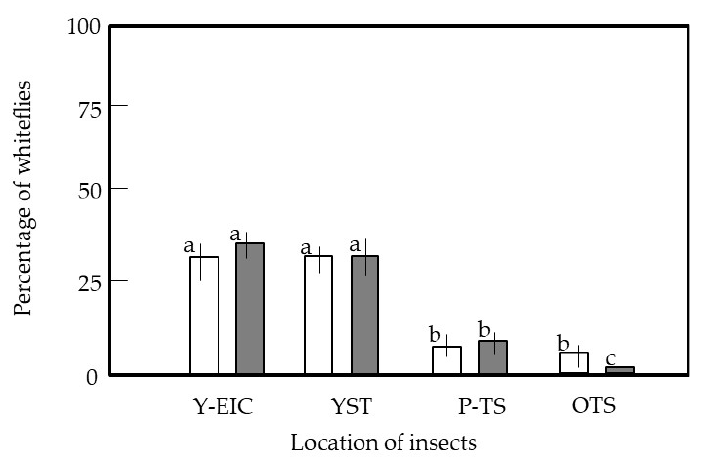
Figure 9. Assay of the preferential attraction of whiteflies to a yellow-colored electrostatic insect catcher (Y-EIC), a yellow sticky trap (YST), and a potted tomato seedling (P-TS), which were placed in concyclic positions at equal distances. A vessel containing test insects was placed at the central position of a circle. Adult whiteflies were used as test insects. In all experiments, the destinations of test insects were recorded 1 day (open) and 2 days (gray column) after their release. OTS represents other places, such as in the vial or on the floor, wall, and ceiling of the cabinet. Twenty insects were used in each experiment, and the means and standard deviations were calculated from five repli- cates of the experiments. The letters a–c in each vertical column indicate significant differences ( p < 0.05) according to Tukey’s test.